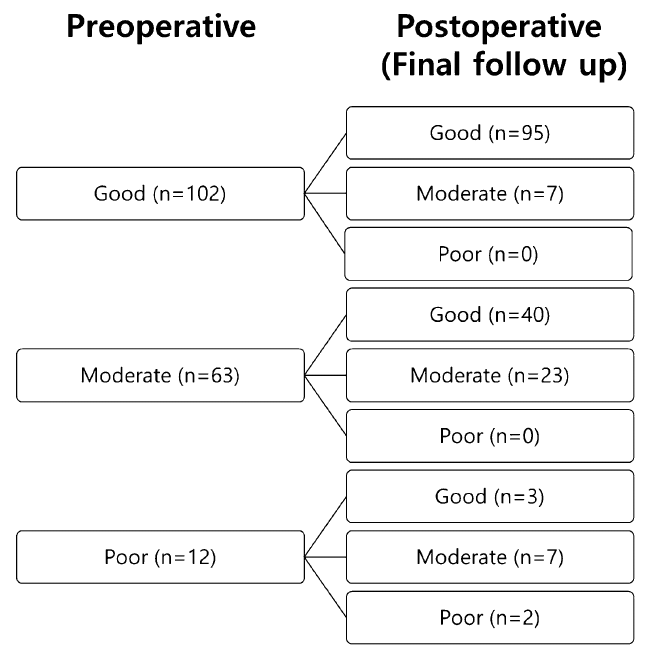
Figure 1. Postoperative changes in the Titmus stereotest results grouped by the preoperative stereoacuity results in Group